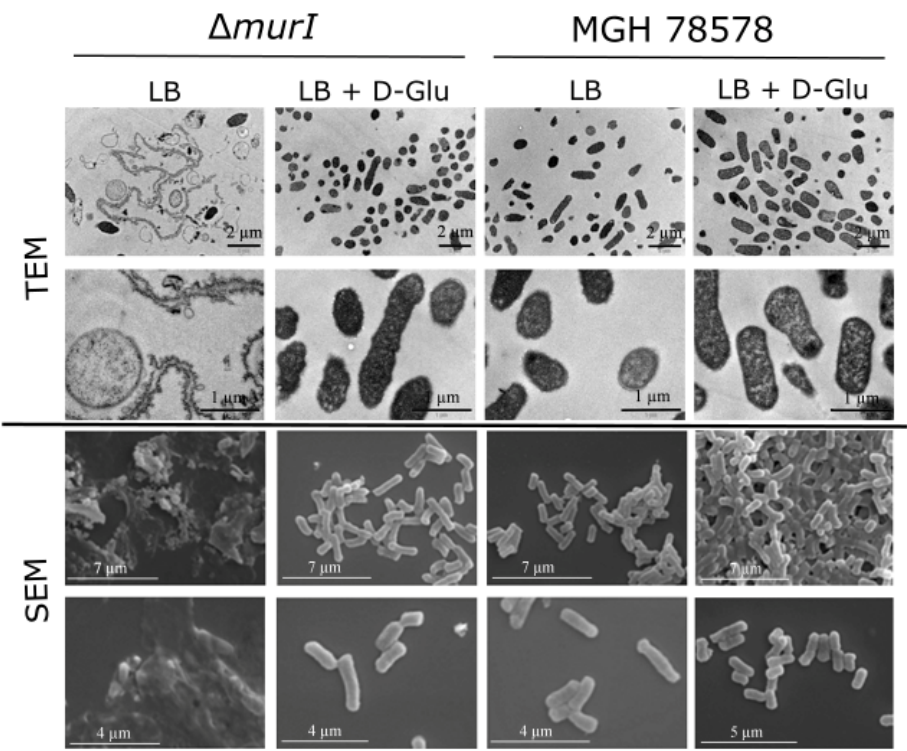
Figure 2. Morphological and structural changes of K. pneumoniae MGH 78578 Δ murI in the absence of D-glutamate. Transmission electron microscopy (TEM, upper panels) and scanning electron mi- croscopy (SEM, lower panels) micrographs, obtained at different magnifications. Images of the wild- type strain are shown as